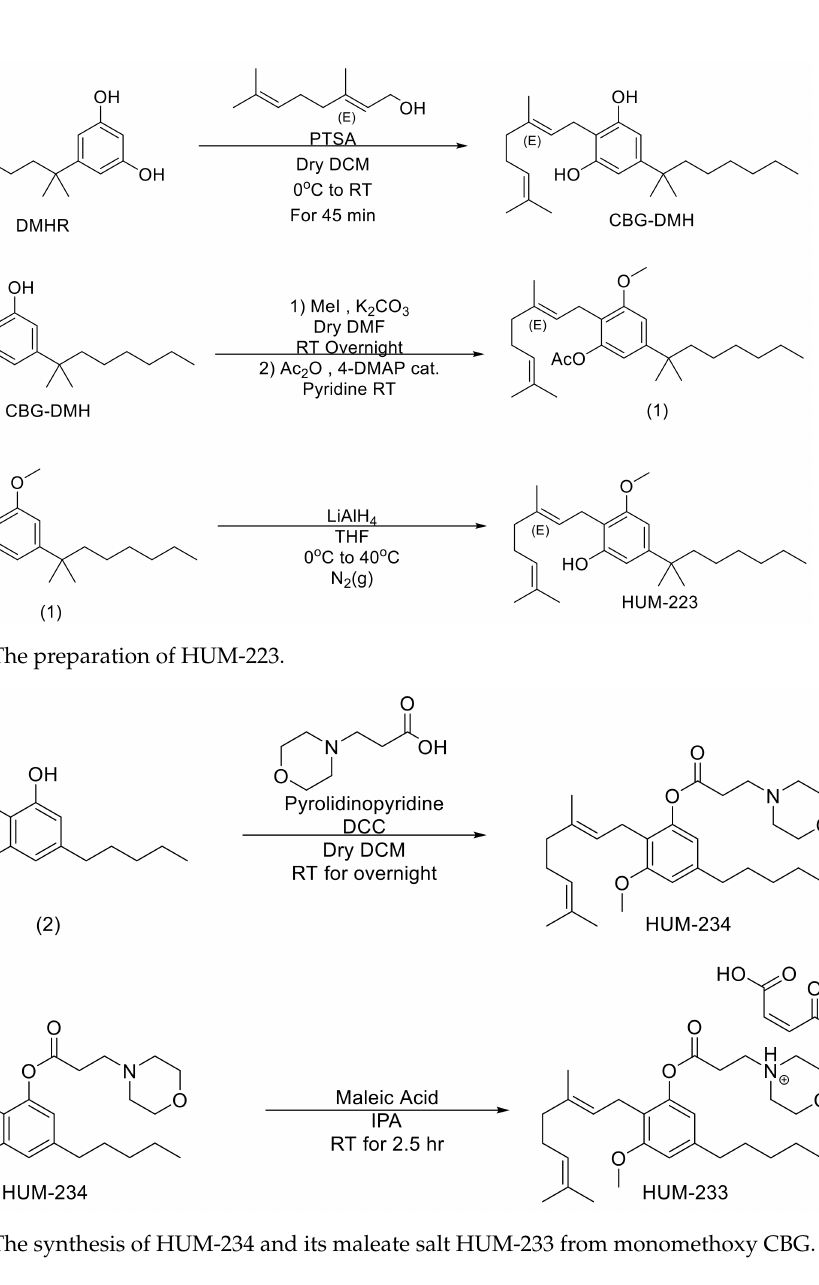
Figure 2. The synthesis of HUM-234 and its maleate salt HUM-233 from monomethoxy